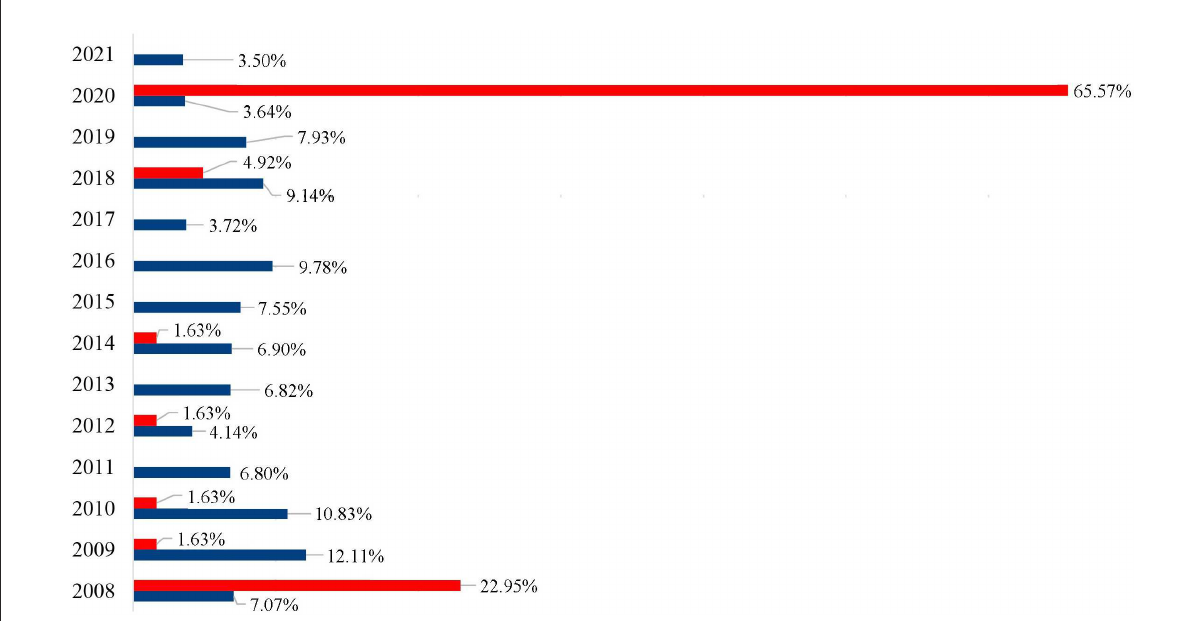
FIGURE2 Percentage of the specimens of Achatina fulica (blue) and Megalobulimus sp. (red) registered per year by the LRNEM Reference Service between 2008 and 2021.